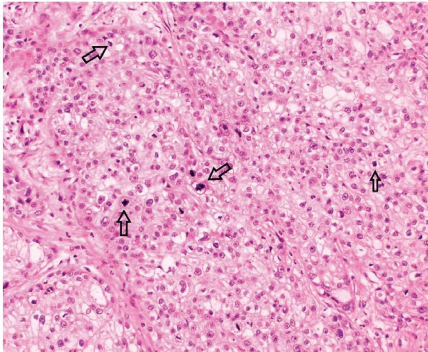
Figure 2: SC at high power (20x magnifcation) shows marked cytologic atypia, abundant clear-staining cytoplasm, and numerous mitotic fgures.